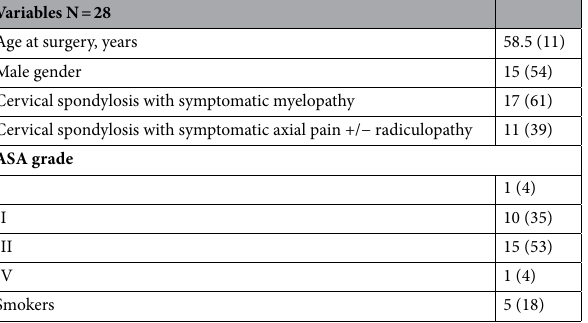
Table 1. Summary of baseline characteristics for patients undergoing four-level ACDF. Descriptive data is presented as number (percentage) or mean (SD). ACDF anterior cervical discectomy and fusion, ASA American Society of Anesthesiologists.